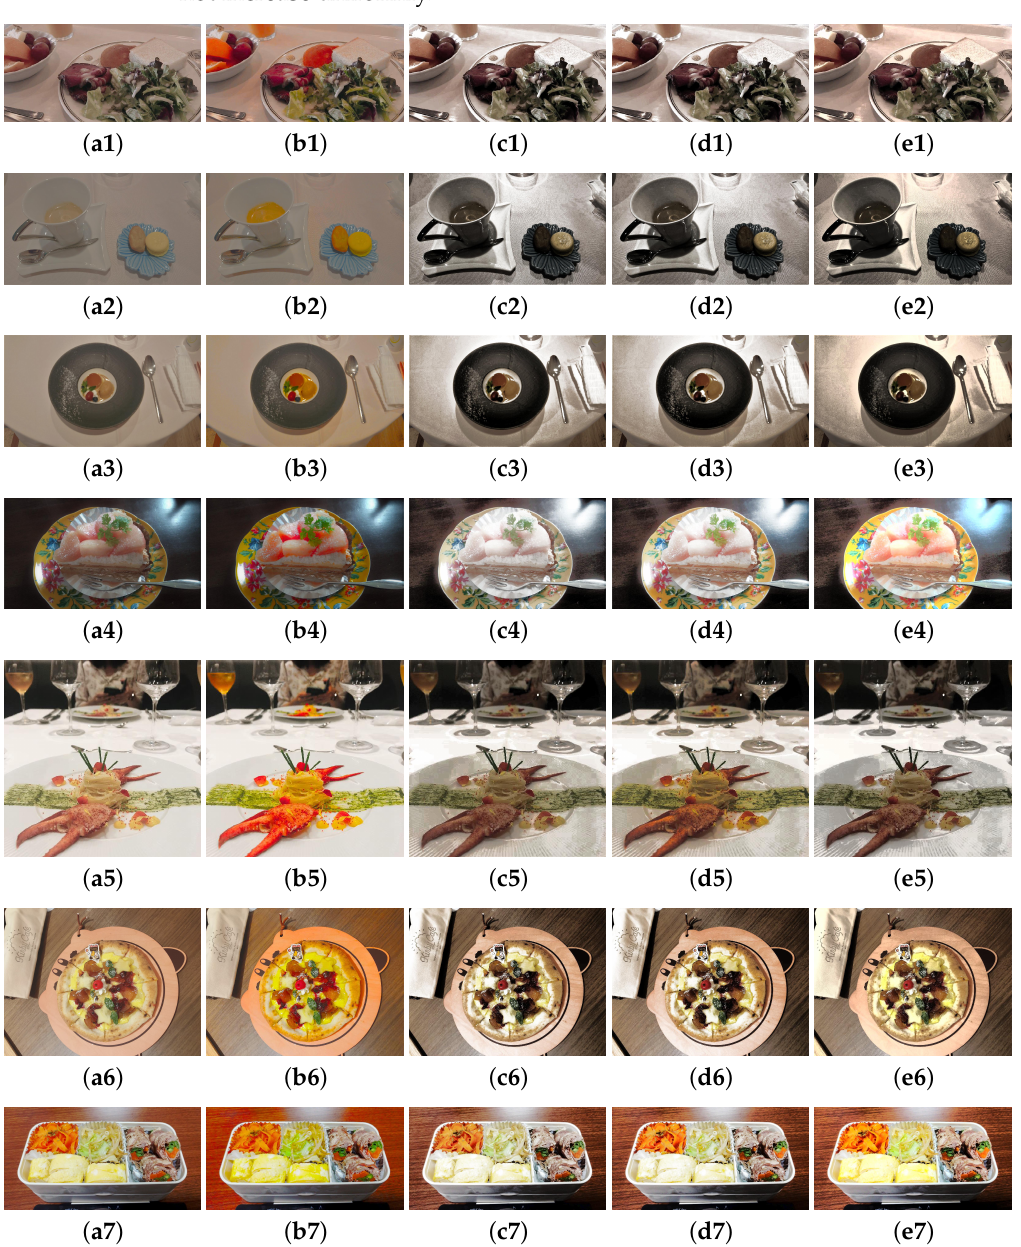
Figure 6. Experimental results. First column ( a1–a7 ): original images. Second column ( b1–b7 ): resulting images using the proposed method with Equation (6). Third column ( c1–c7 ): resulting images using the method in Ref. [2] using histogram equalization. Fourth column ( d1–d7 ): resulting images using the method in Ref. [6] using histogram equalization. Fifth column ( e1–e7 ): resulting images using the method in Refs.